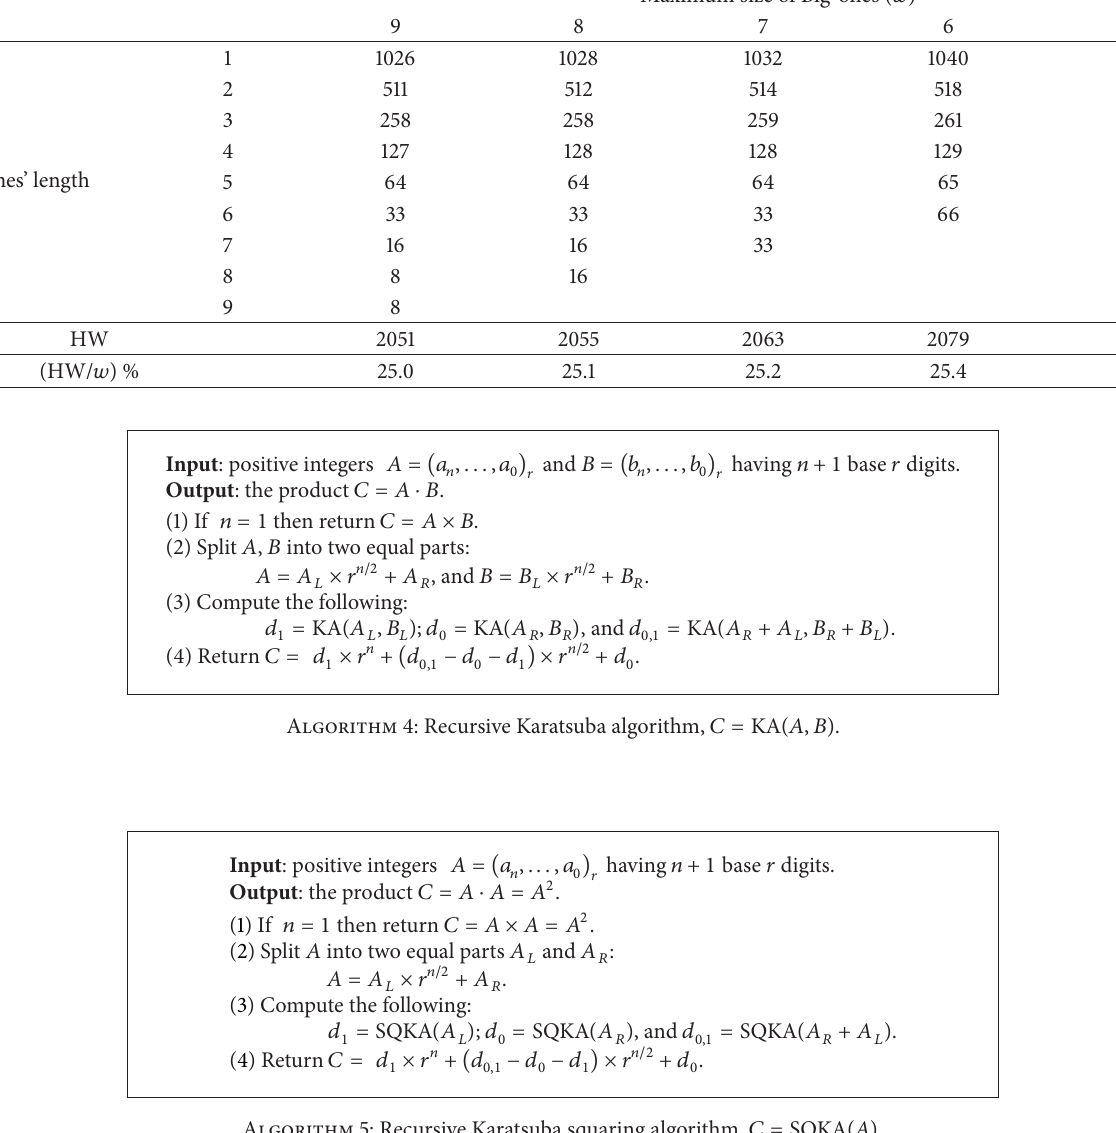
Table 3: Big-ones’ distribution in an 8-Kbit binary number in LCBONS for different Big-one’s length. Maximum size of Big-ones ( 𝑤 )